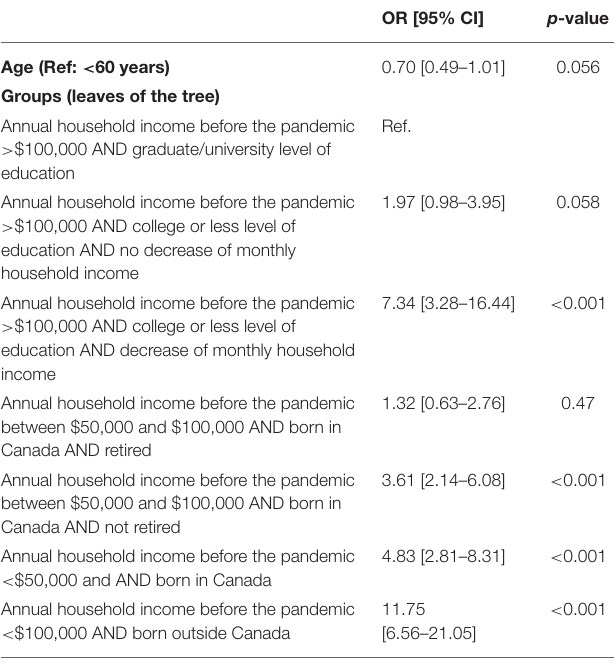
TABLE 3 | Optimal hybrid tree-based model (GPLTR) analysis for vaccine